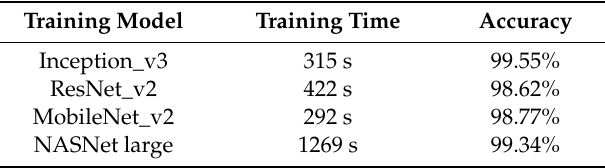
Table 3. Comparison of the results in di ff erent training